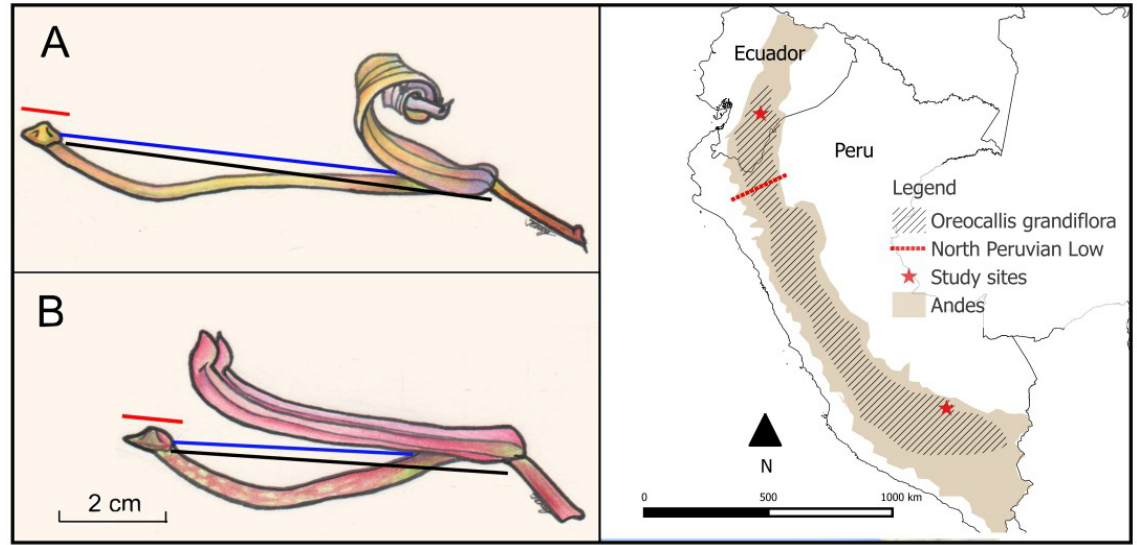
F IGURE 1. There is marked variation in floral morphology between Peruvian (A) populations at the southern range limit and Ecuadorian (B) populations at the northern range limits of Oreocallis grandiflora. Blue lines indicate the straight line distance between the tip of the pollen presenter and the point at which nectar accumulates (PED), back lines indicate the style length (SL), and red lines indicate stigma height (SH). On the map the red drops represent the study site locations in Ecuador and Peru, the dotted line represents an estimate of the range of O. grandiflora, and the double black line represents the location of the Northern Peruvian